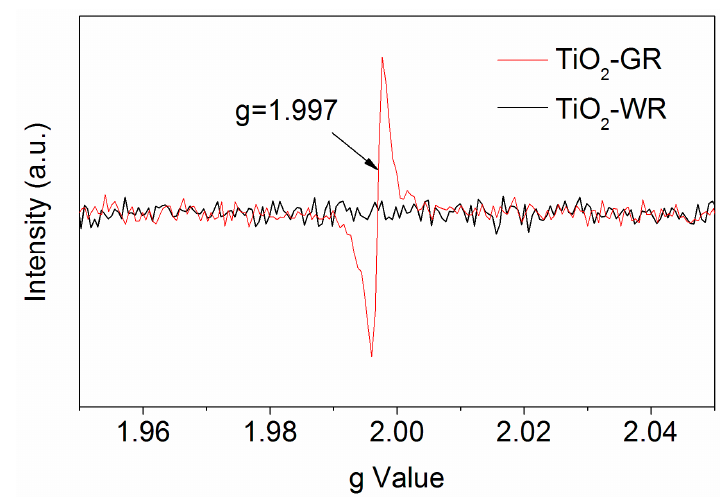
Figure 4. EPR spectroscopy of TiO 2 -GR (red line) and TiO 2 -WR (black line).